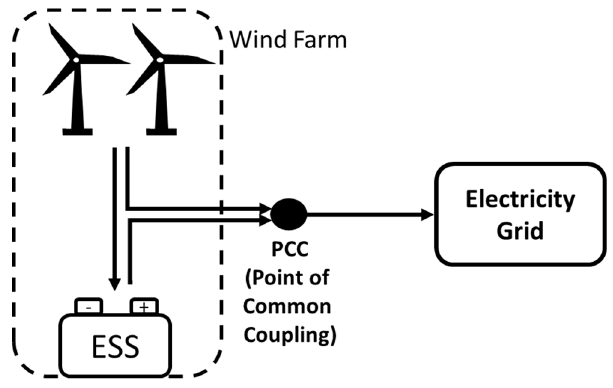
Figure 1. A coordinated model of a wind farm with an energy storage system (ESS).